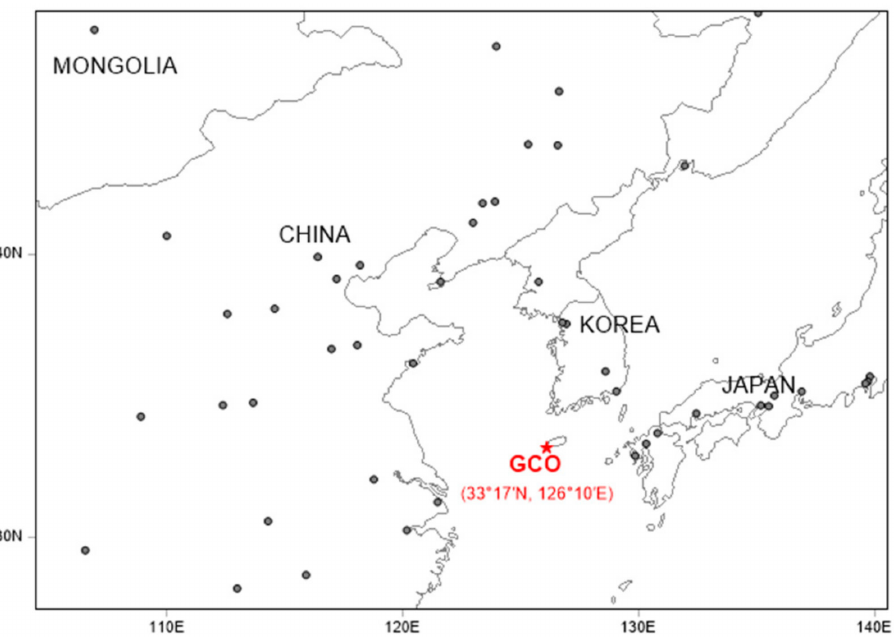
Figure 1. The map showing the Gosan Climate Observatory (GCO) site (black dots) in the western- most part of Jeju Island, South